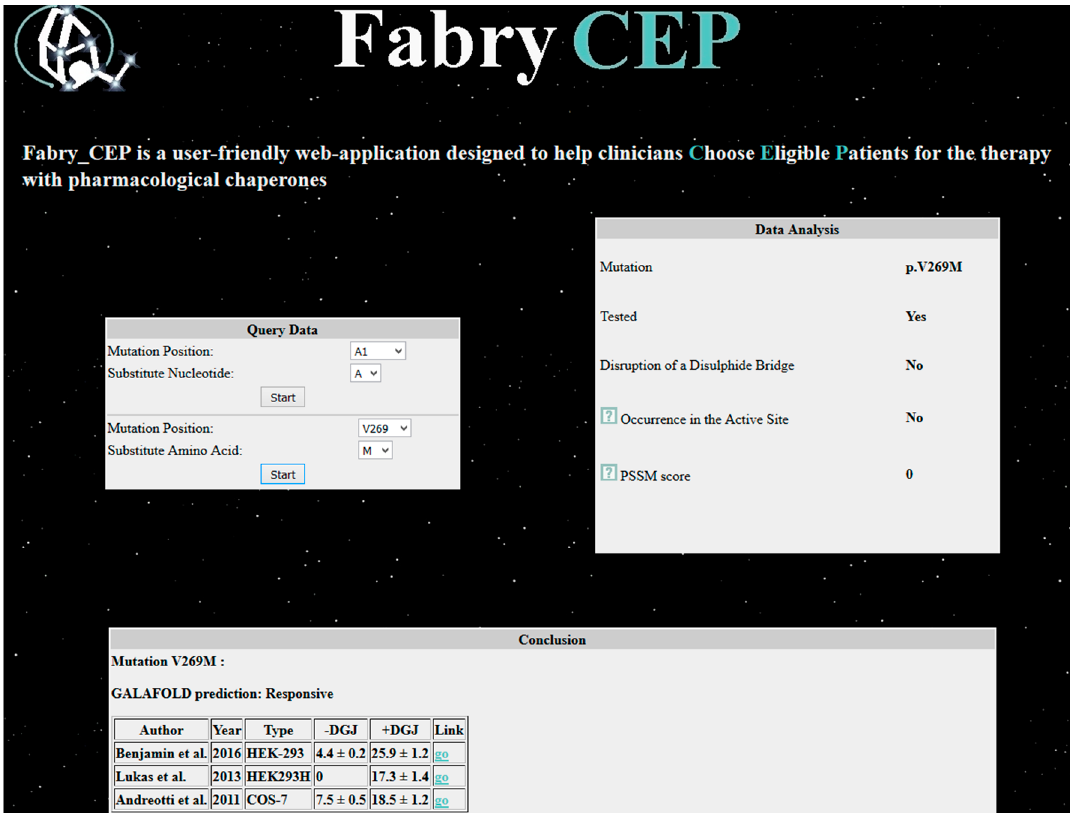
Figure 5. Output of Fabry_CEP.